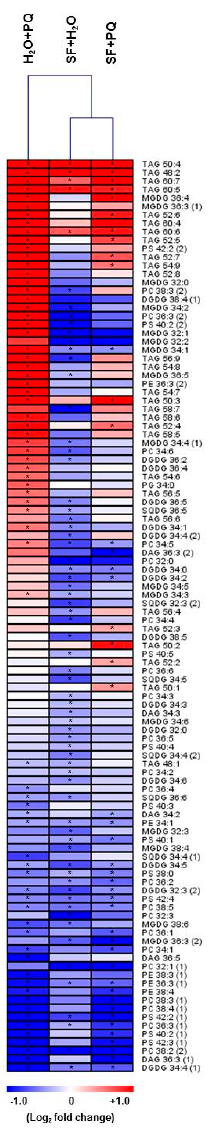
Figure 7. Lipid changes induced by oxidative stress. Changes in the abundances of lipids in Arabidopsis leaves after foliar spray with PQ and/or SF. Blue and red depict decreases and increases, respectively, compared to the control (unprimed and unstressed, i.e., H 2 O + H 2 O). Data are given in log 2 fold change; only lipids significantly different from control samples are shown (highlighted by an asterisk). The data are averages of seven biological replicates. Samples: PQ-stressed (H 2 O + PQ), SF-primed but unstressed (SF + H 2 O), and SF-primed and stressed (SF + PQ). Statistically significant differences to control are highlighted by asterisks (at the significance level of 0.05, FDR corrected). Full data are given in Supplementary Materials Data S6. DAG: diacylglycerol; TAG: triacylglycerol; MGDG: monogalactosyldiacylglycerol; DGDG: digalactosyldiacylglycerol; PC: phosphatidylcholine; PE: phosphatidylethanolamine; PG: phosphatidylglycerol; PI: phosphoinositol; PS: phosphoserine; and SQDG: sulfoquinovosyldiacylglycerol.